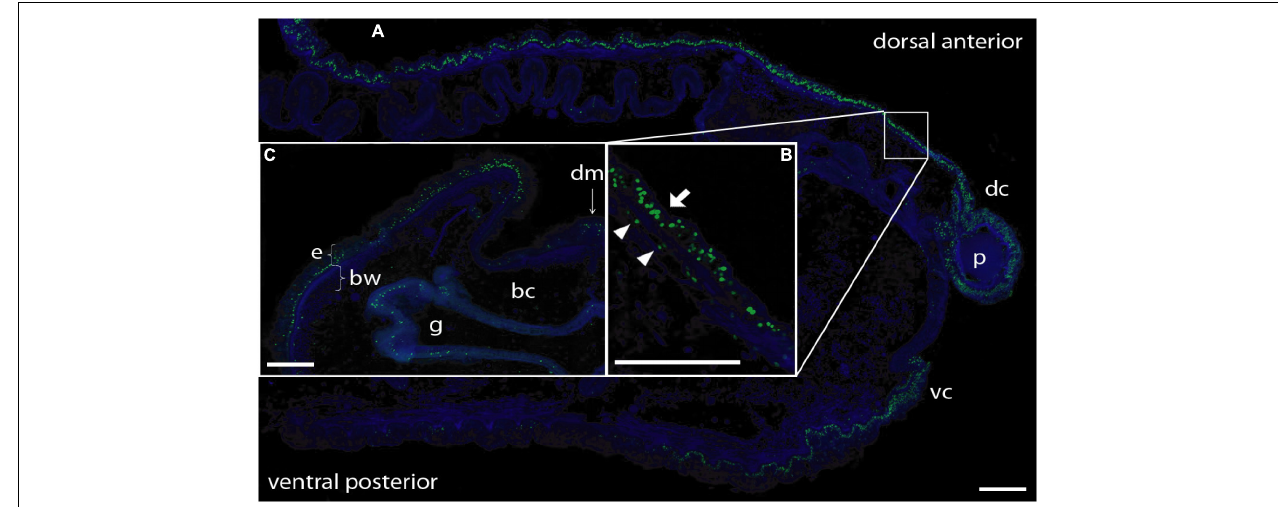
FIGURE 2 | BrdU labeling of nuclei during anterior regeneration. Green indicates BrdU-labeled nuclei. Blue is DAPI staining for all nuclei. Scale bars = 0.3 mm. (A) Anterior sagittal section of an animal with a regenerating proboscis at 6 days post-amputation (dpa). Many nuclei synthesizing DNA are distributed in the blastema/regenerating proboscis and in cells of the ectodermal columnar epithelium around the blastema, extending considerably more posterior in the dorsal epithelium. (B) Inset: Enlargement of the area from the small square in (A) . Most labeled nuclei are in the epithelium (arrow), but there is a small set of mesenchymal-labeled nuclei (arrowheads) below the basement membrane of the epithelium (staining of basement membrane not shown in this image). (C) Lateral dorsal quadrant of a body cross section posterior to a regenerating blastema at 5 dpa. Nuclei incorporating BrdU are distributed in the dorsal lateral epithelium from the dorsal midline to the lateral edge. The ventral epithelium (not shown) contains few labeled nuclei. Labeling in the gut wall is the same as in non-regenerating animals. Acquired microscopic data were composed into a single image for each sample. bc, body cavity; bw, body wall (mesodermal); dc, dorsal collar; dm, dorsal mesentery; e, epithelium (ectodermal); g, gut cavity; p, proboscis; vc, ventral